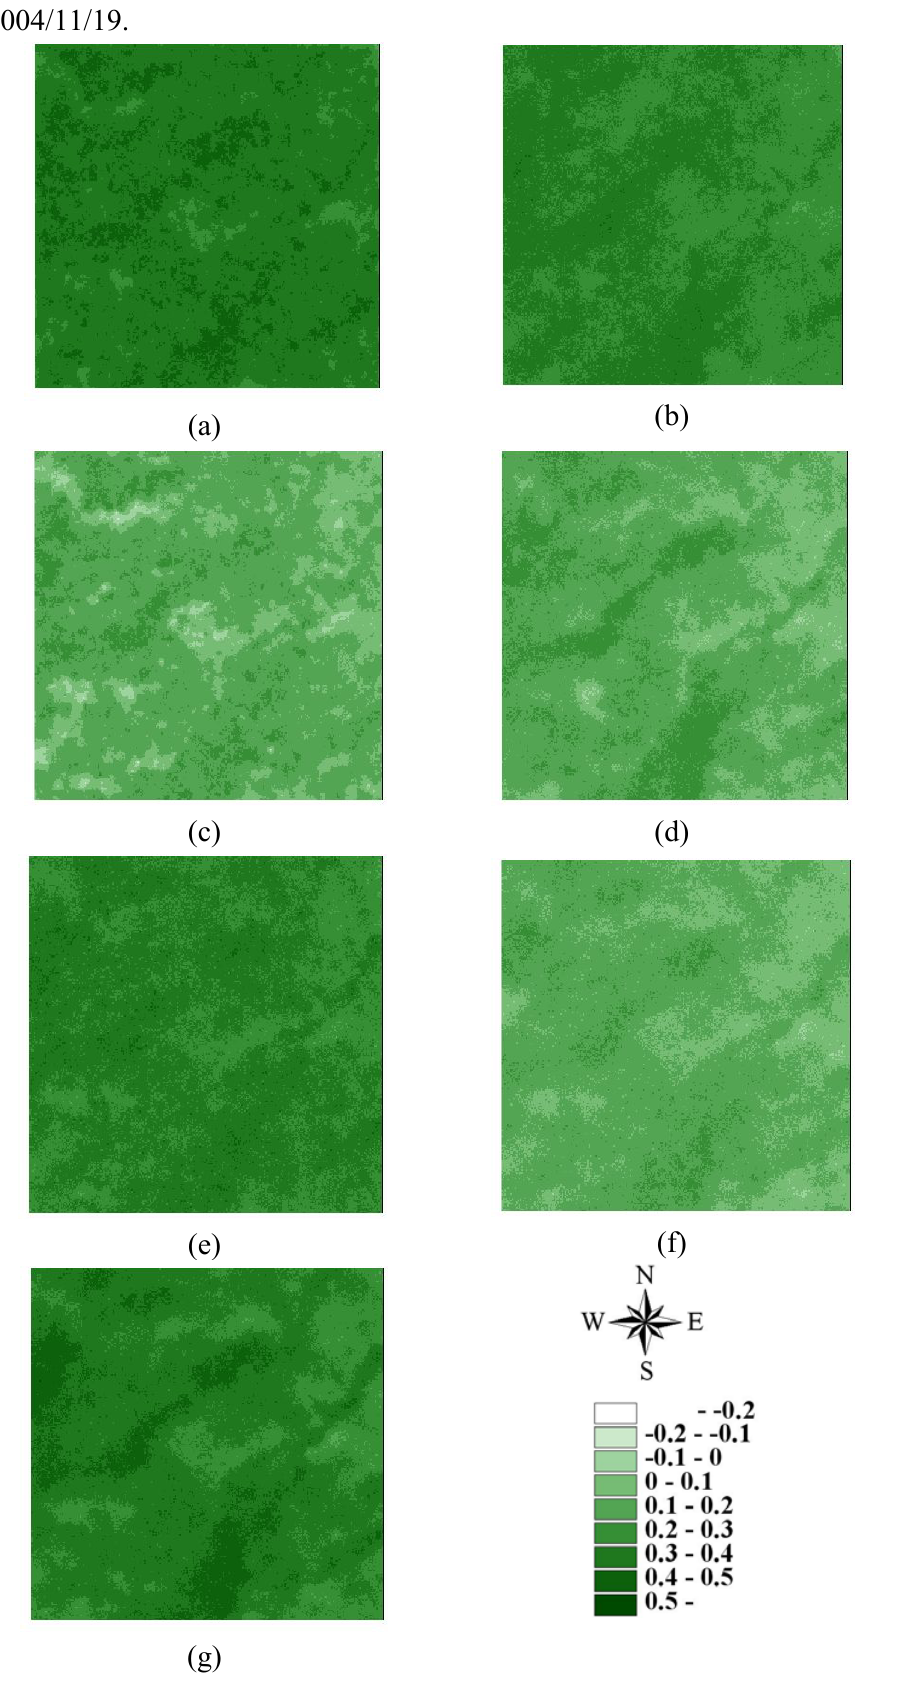
Figure 11. Conditional simulated NDVI images based on 3,000 samples for area B on (a) 1996/11/08, (b) 1999/03/06, (c) 1999/10/31, (d) 2000/11/27, (e) 2001/11/20, (f) 2003/12/17, and (g)